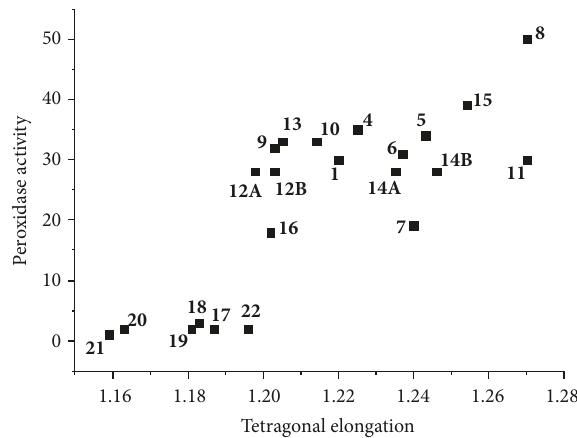
Figure 10: Peroxidase activity, expressed as percentage of ABTS conversion into ABTS ∙+ , in function of the tetragonal elongation of the catalyst, expressed as the ratio between the Mn-O axial and Mn- O equatorial distances in crystal structures 1 and 4 – 22